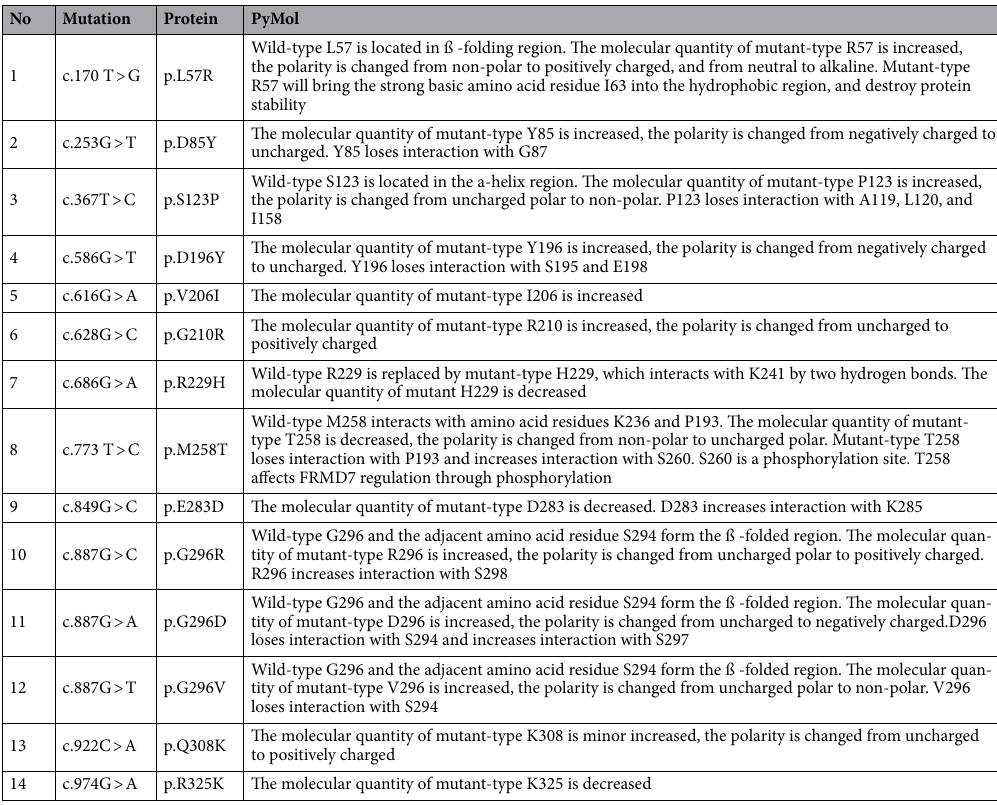
Table 2. Description of PyMol structure prediction for 14 novel missense